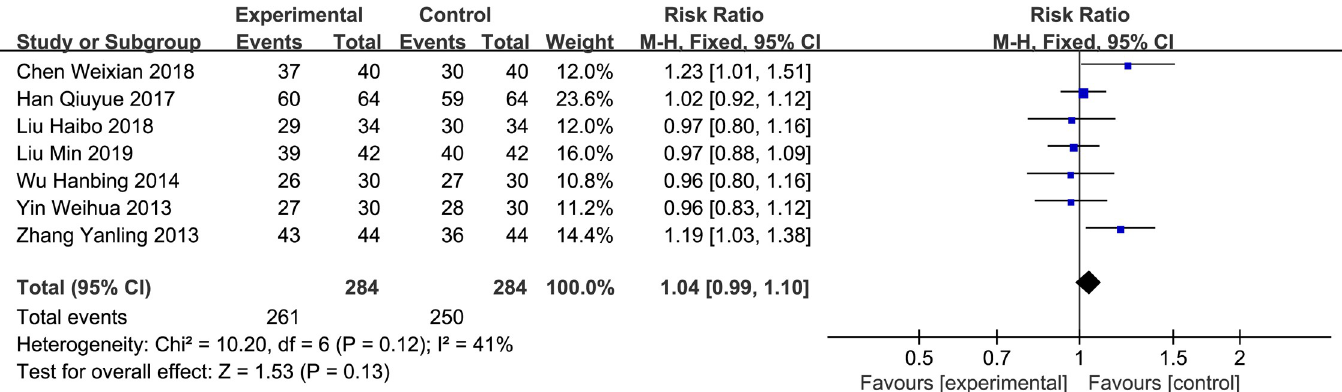
Fig 5. Forest plot of effective rate of pain control between experimental and control